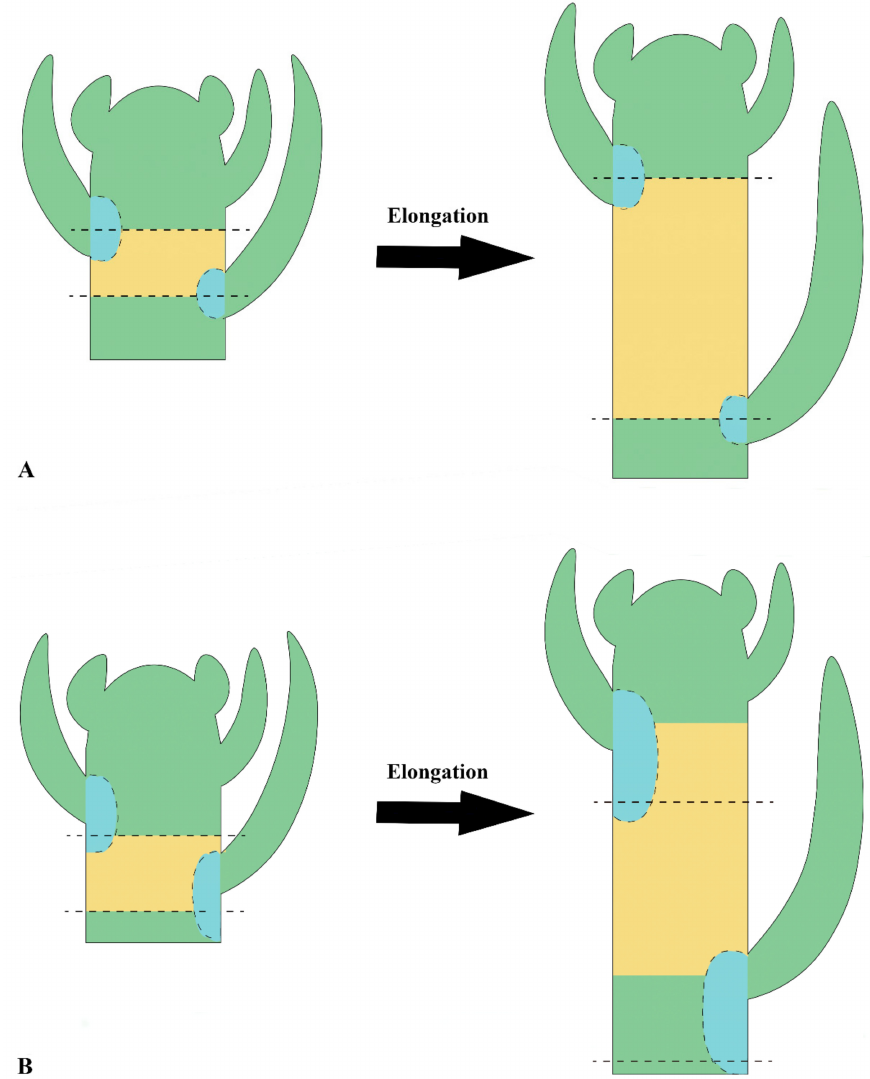
Figure 5. Schematic drawings of two stages of shoot development. ( A ) Regular shoot development. Note that the leaf-base participation in the axis is restricted to its point of origin at the node, even after the internode elongation. ( B ) Shoot of Euphorbia attastoma and E. tetrangularis . Note that adnate leaf-base forms an axial component, displacing the leaf to a region above the node. The fused portion elongates along with the internode. The origins of axial tissues were colored in one plastochron. Dashed line: node; blue: leaf-base component; yellow: cauline component; green: indiscriminant